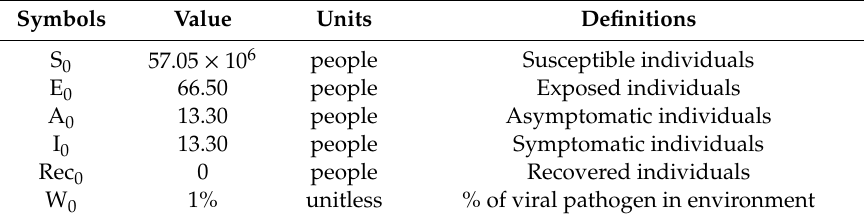
Table 1. Definitions and initial values for the populations represented by each compartment: the values here are the averages of the model values across all countries developed in a prior COVID-19 study [22].